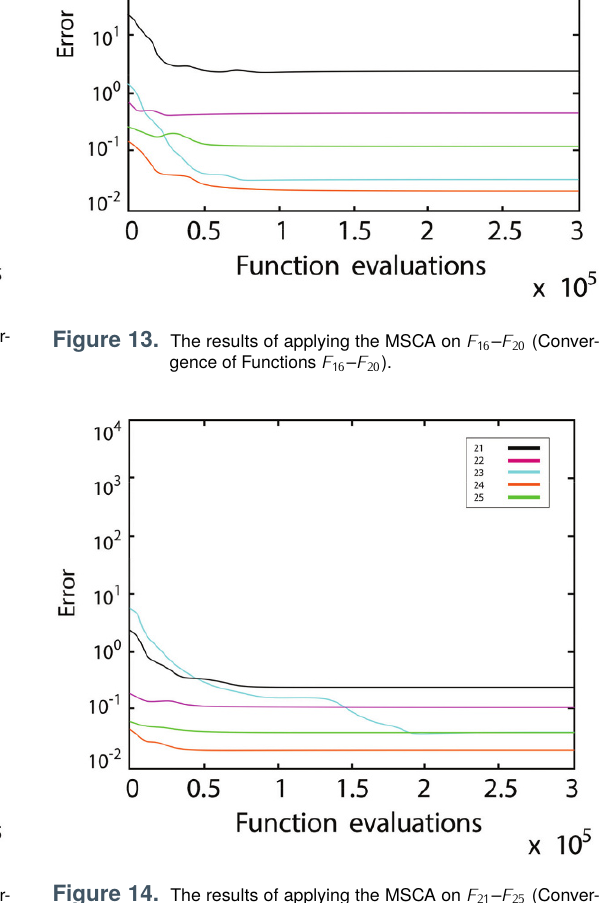
examining and optimizing multi-model problems. The rea-